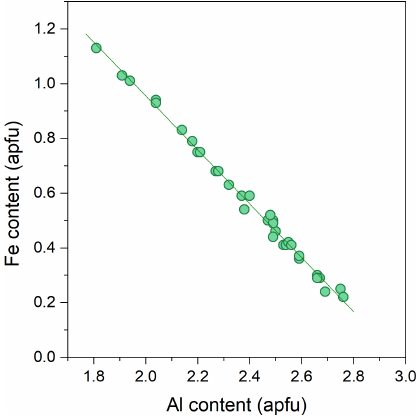
Figure 3. Variation in Al and Fe content (apfu); the line is a linear fit to the data points with R 2 = 0 . 99.